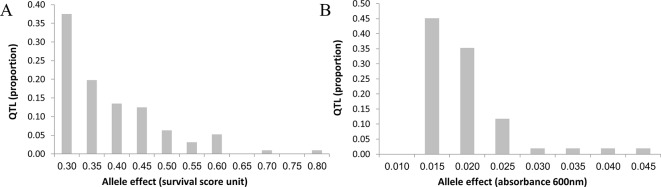
Distribution of QTL allele effects for survival and growth. The average effects for the three top markers in each QTL was used to estimate the QTL effect (the X axis). The distributions differ in detail, but both show complete absence of QTL of large effect, very low frequency of QTL of moderate effects, and a very large number of QTL of small effect. Thus, distributions differ from the infinitesimal model, in that the almost all variation is in QTL of small, but mappable effect; but also differ from typical QTL model in the complete absence of QTL of large effect, and paucity of QTL of moderate effect. (A) Survival. (B) Growth.